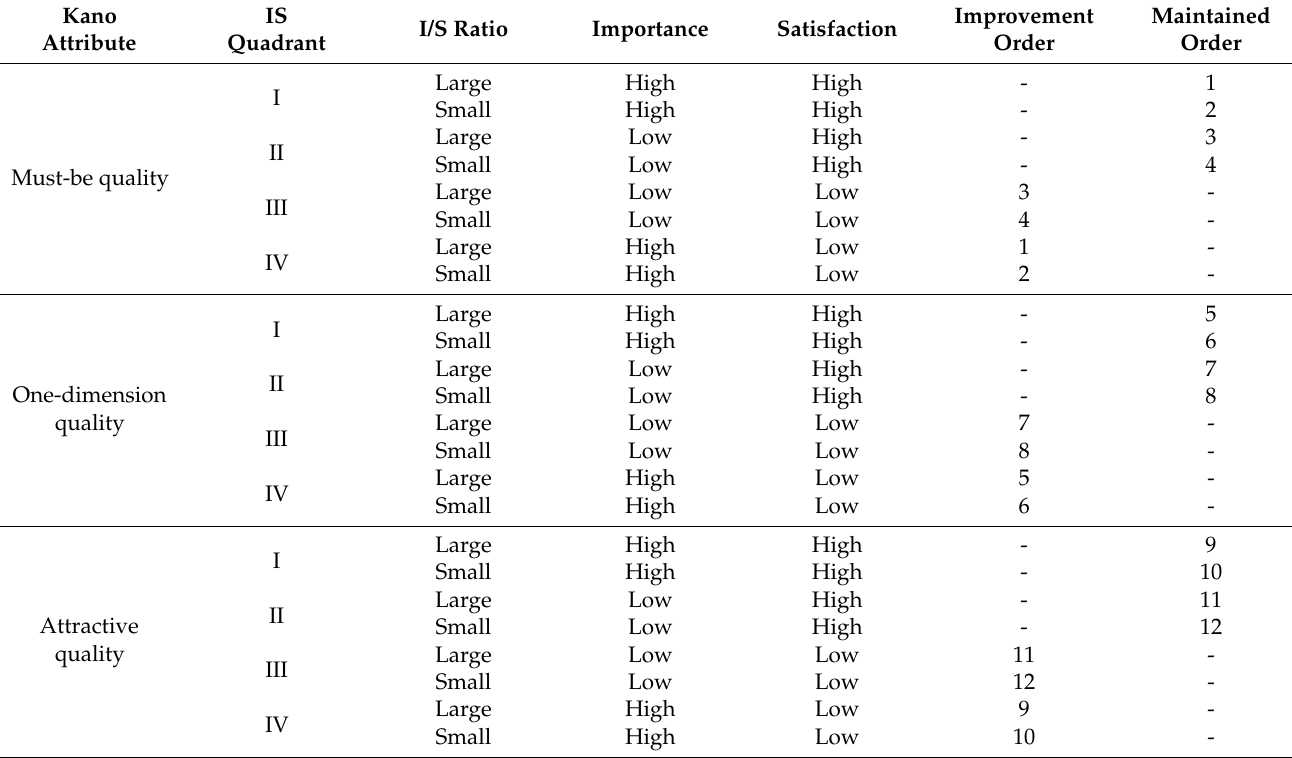
Table 3. Decision sequence of quality